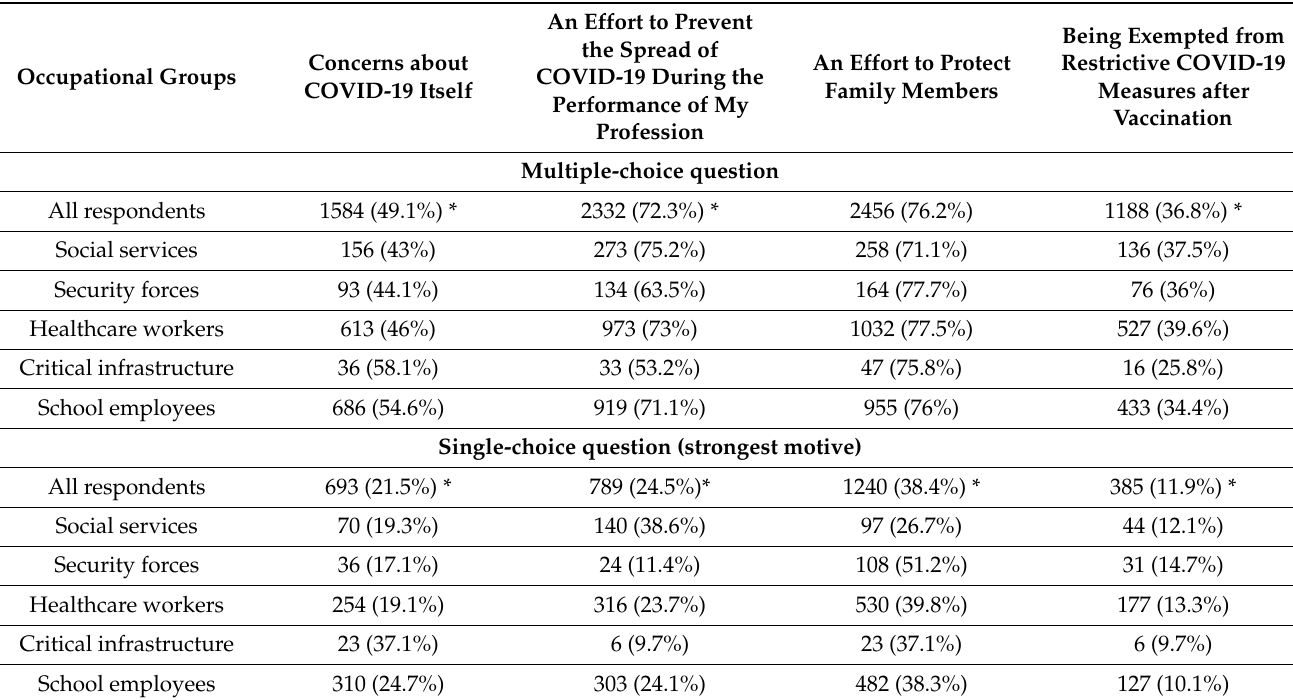
Table 2. Motives for vaccination against COVID-19 and the frequency of their